Question: Give a one-sentence summary of this figure.
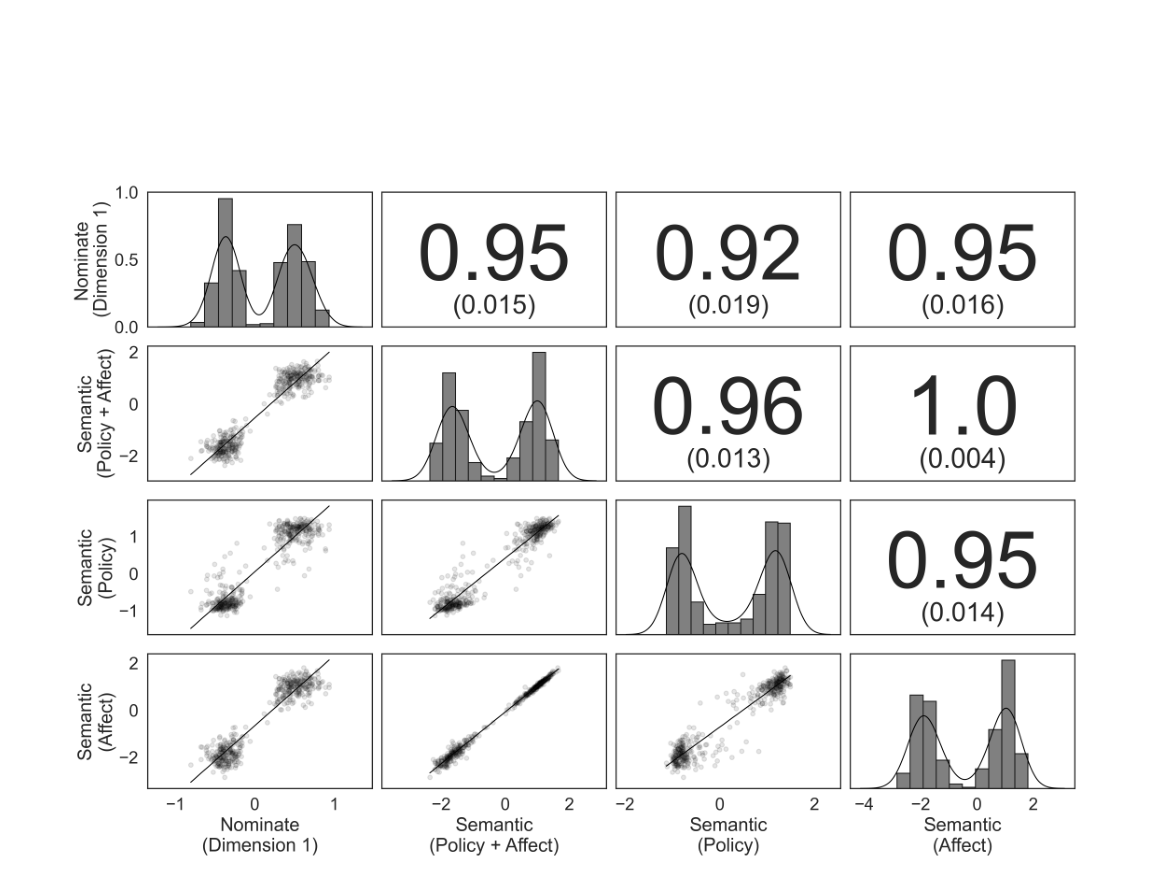
Answer: The correlations and standard errors between Semantic Scaling and DW-NOMINATE demonstrate that Semantic Scaling is able to recapture the distribution of DW- NOMINATE.